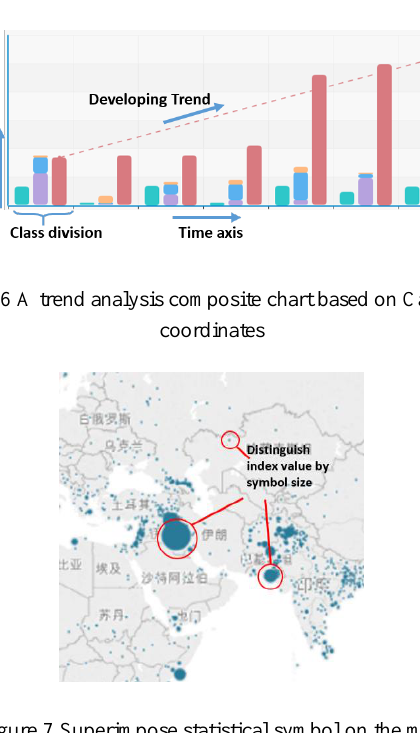
Figure 7 Superimpose statistical symbol on the map Proportion charts : including pie charts, donut charts, rose charts, radar charts, rectangular tree charts, etc. Proportion analysis charts are based on Polar coordinate system, including pie charts, donut charts, rose charts and so on. This king of chart is focused on analysing the components and component composition of event’s property. Pie charts, donut charts and rose charts focus on analysing the contrast between the constituent components. Central angle is used to record the size of each component, the length of radius or the area of circle or sector is used to record the statistic value of each component, with different colours to distinguish between the various components. Proportion analysis charts mainly used for threaten region and target analysis.